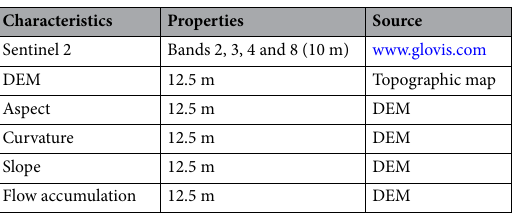
Figure 1. Various predisposing variables for volcanic and glacial landforms mapping, including ( a ) DEM, ( b ) aspect, ( c ) curvature, ( d ) slope, ( e ) flow accumulation, and ( f ) Sentinel-2 image.